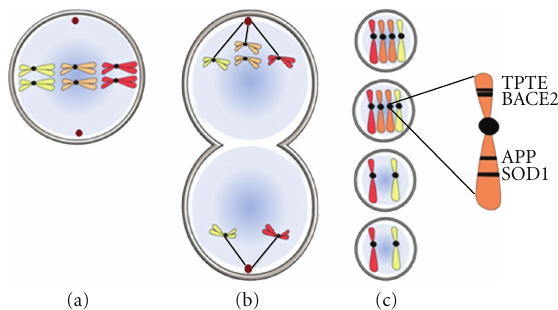
Figure 1: Chromosomal nondisjunction. (a) Most often Down syndrome (DS) occurs as an error in meiosis I (usually in the oocyte). Chromosomal nondisjunction, or improper segregation of chromosome 21 (the smallest autosome; orange), results in one precursor cell having 2 copies (b), upper half) while the other has zero (b), lower half). (c) Meiosis II then proceeds, with the outcome being two gametes that possess an extra copy of chromosome 21 which, after fusion with another gamete, bears 3 copies of chromosome 21; the genetic condition known as DS or trisomy 21. Also produced in this process are two nonviable gametes that possess zero copies of chromosome 21